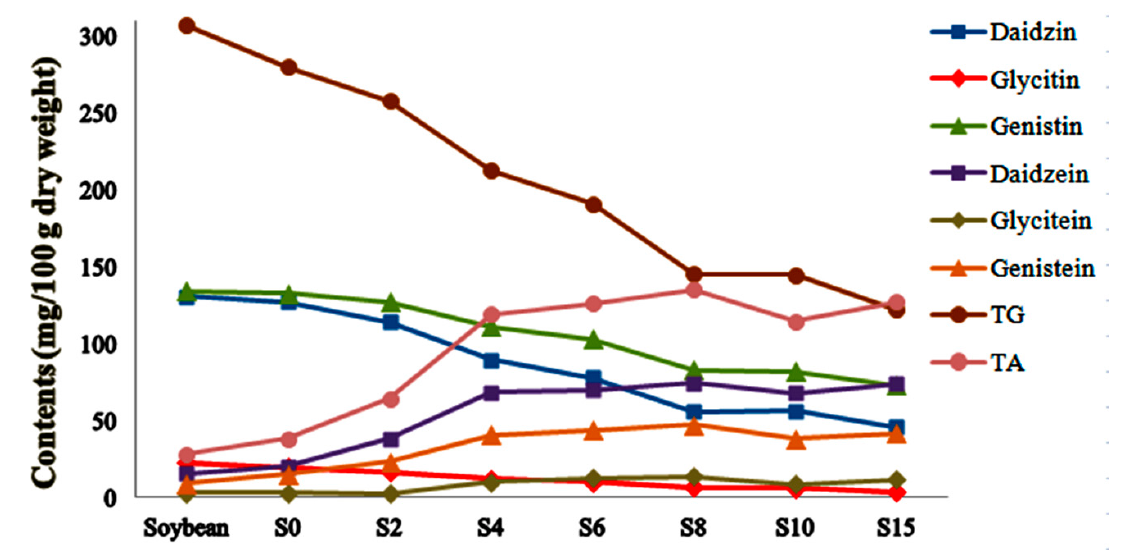
Figure 6. Content profile plots for six isoflavones, total glycoside (TG), and aglycone (TA) in SSP products collected at different fermentation stages.